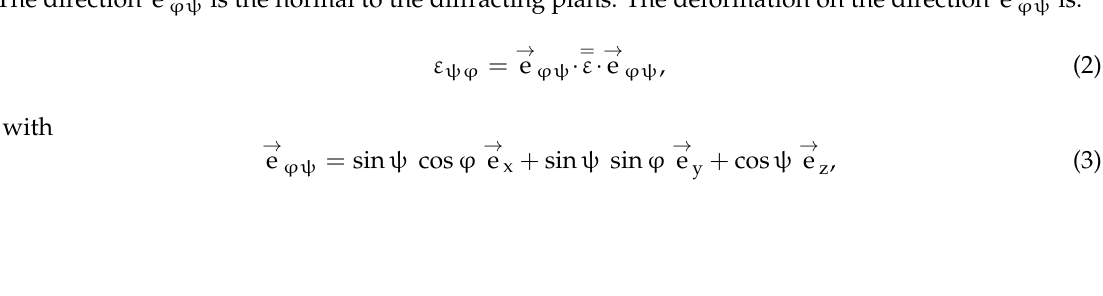
Figure 4. Directions and axes of measurement.